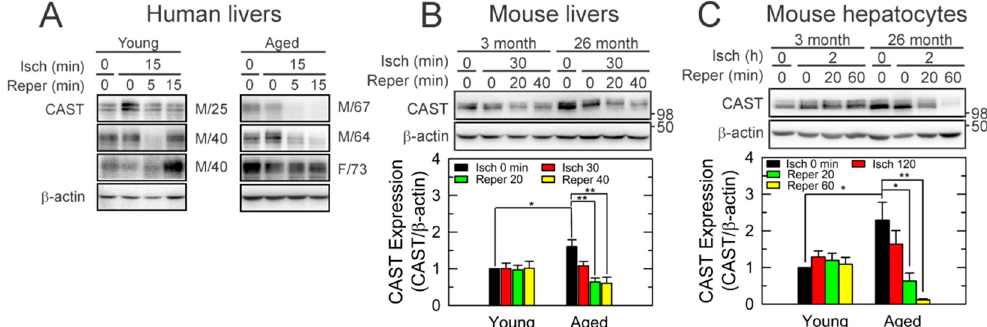
Figure 1. Loss of CAST after short I/R in aged livers. IB analysis of CAST in ( A ) human livers ( n = 6), ( B ) mouse livers ( n = 4), and ( C ) isolated mouse hepatocytes ( n = 4). Liver tissues and hepatocytes at different ages were collected at the end of in vivo and in vitro ischemia (Isch) and during reperfusion (Reper). Changes in CAST were normalized to β -actin. * p < 0.05 and ** p < 0.01.